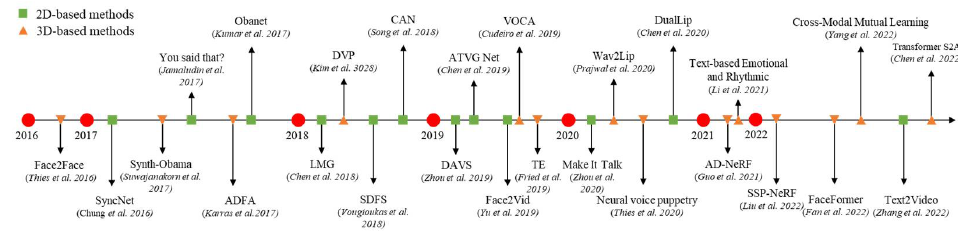
Figure 1. An overview of recent works on talking-head generation [3,7-31].